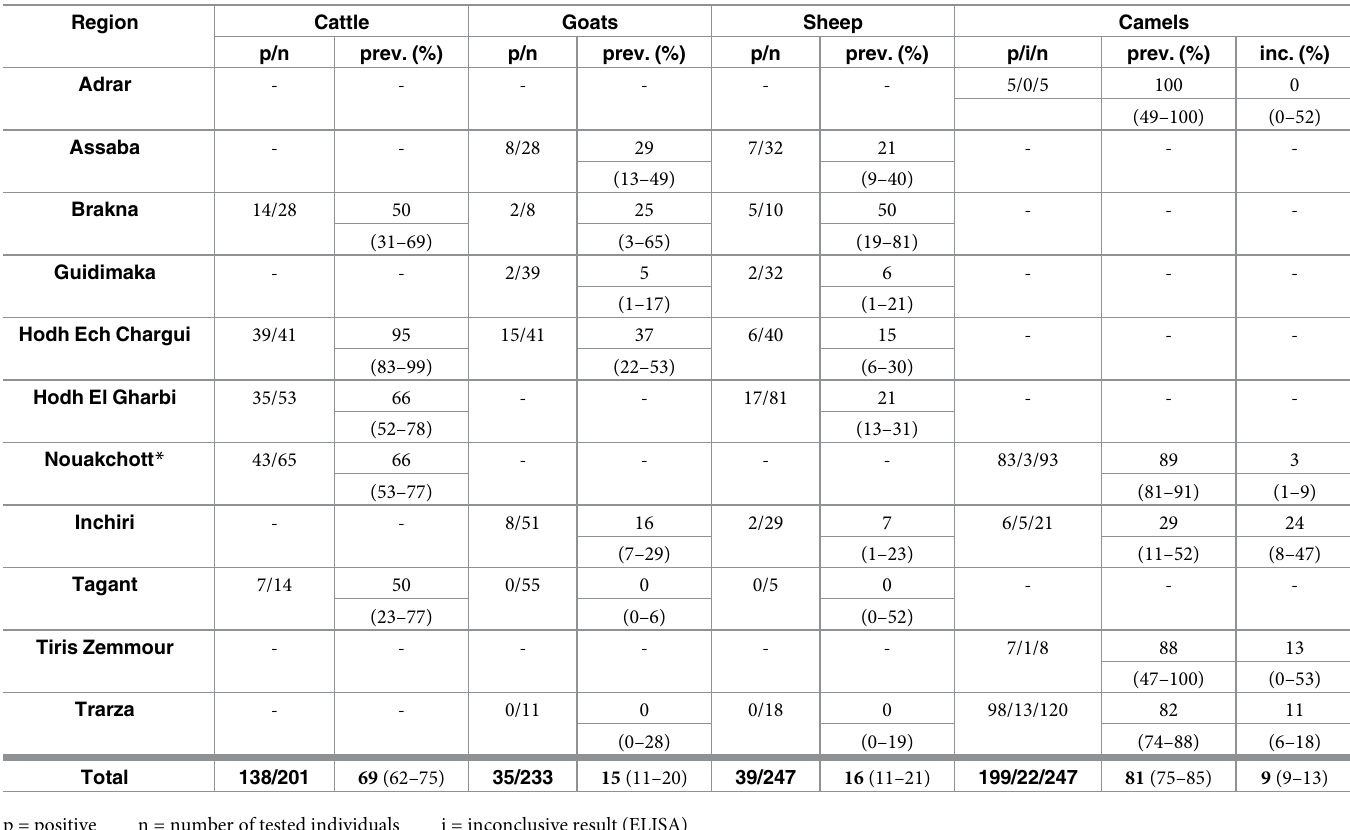
Table 1. Results of seroepidemiogical studies in cattle, goats, sheep and camels in Mauritania. Region